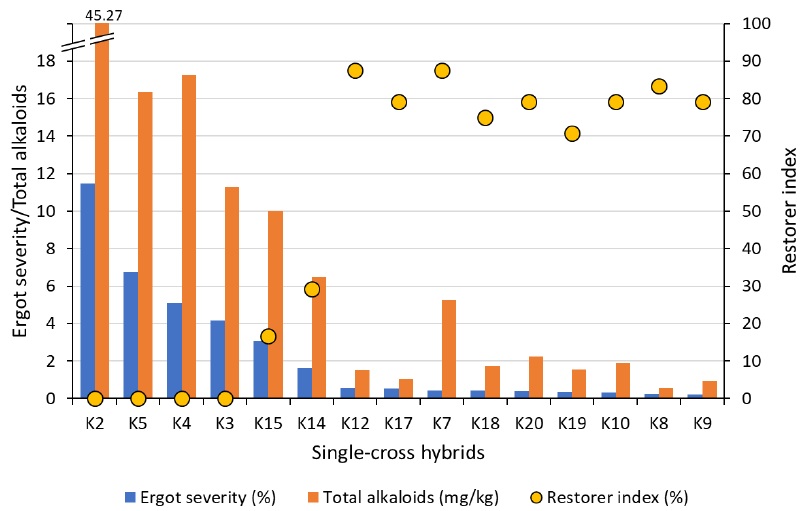
Figure 7. Association between ergot severity, total alkaloid content, and restorer index for 15 single- cross hybrids with and without Rfp1 across two location-year combinations (Data source: [10]).